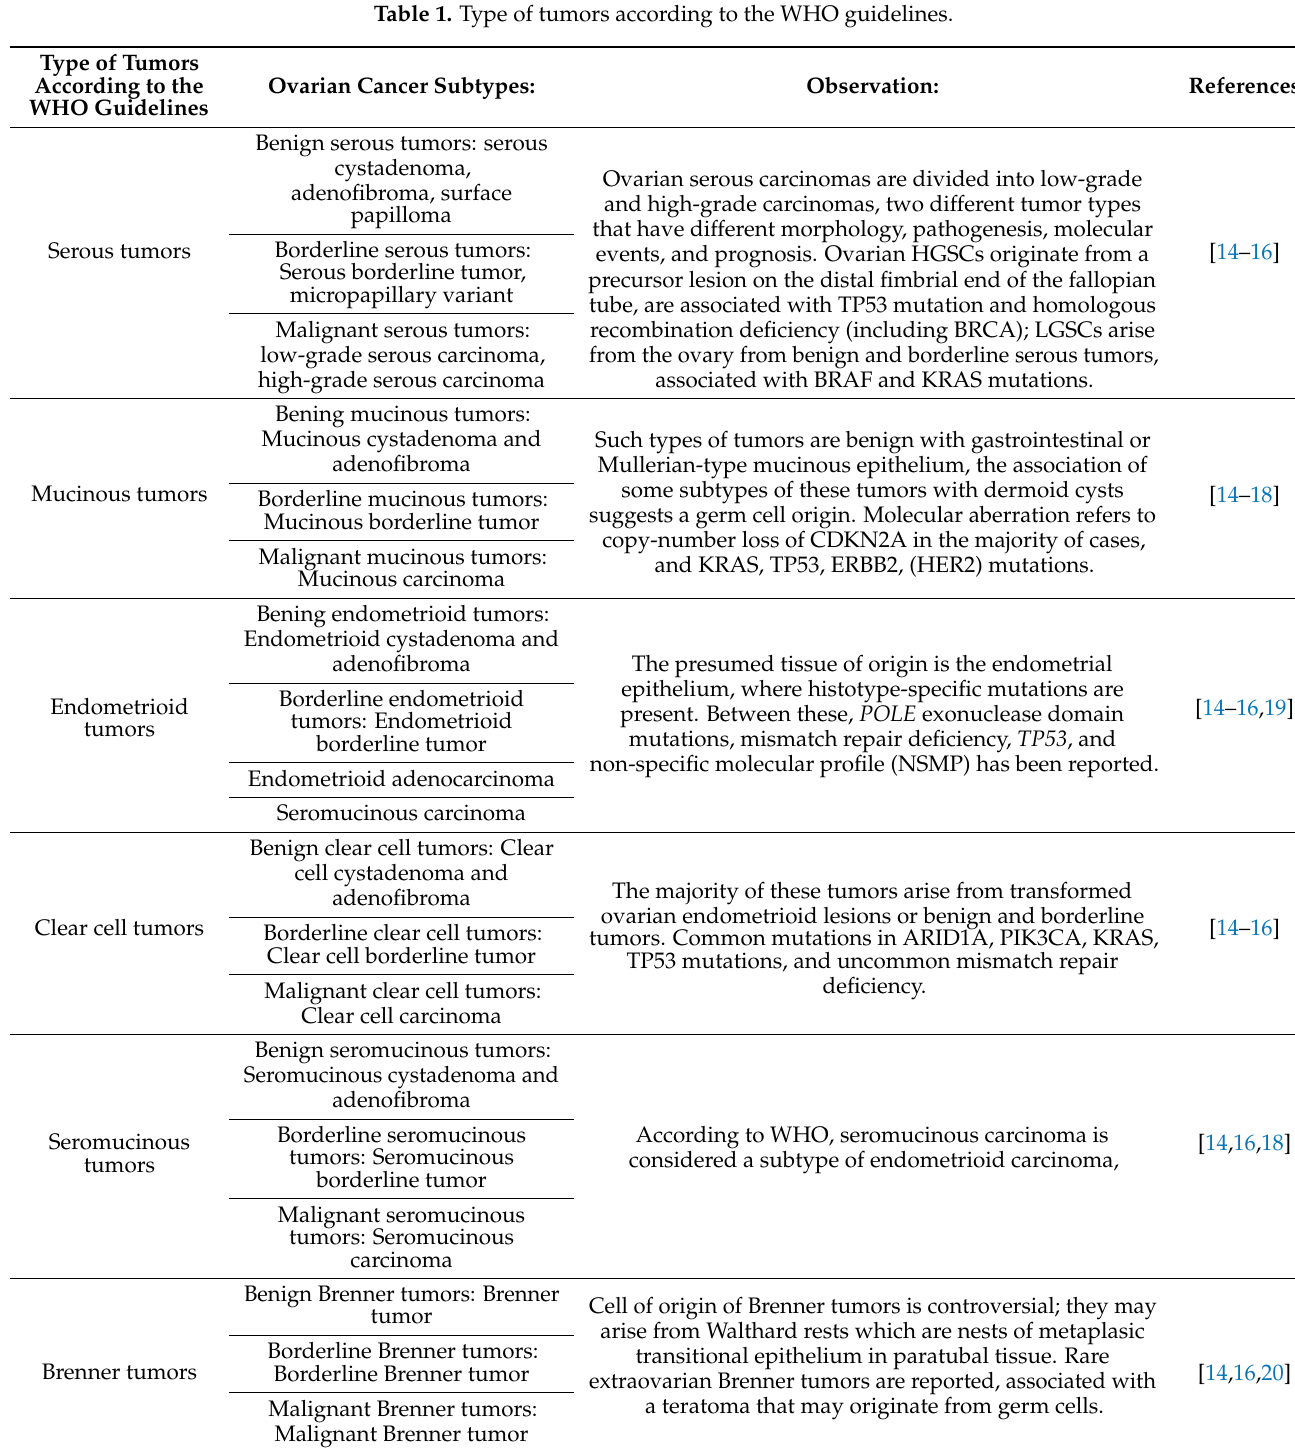
Table 1. Type of tumors according to the WHO